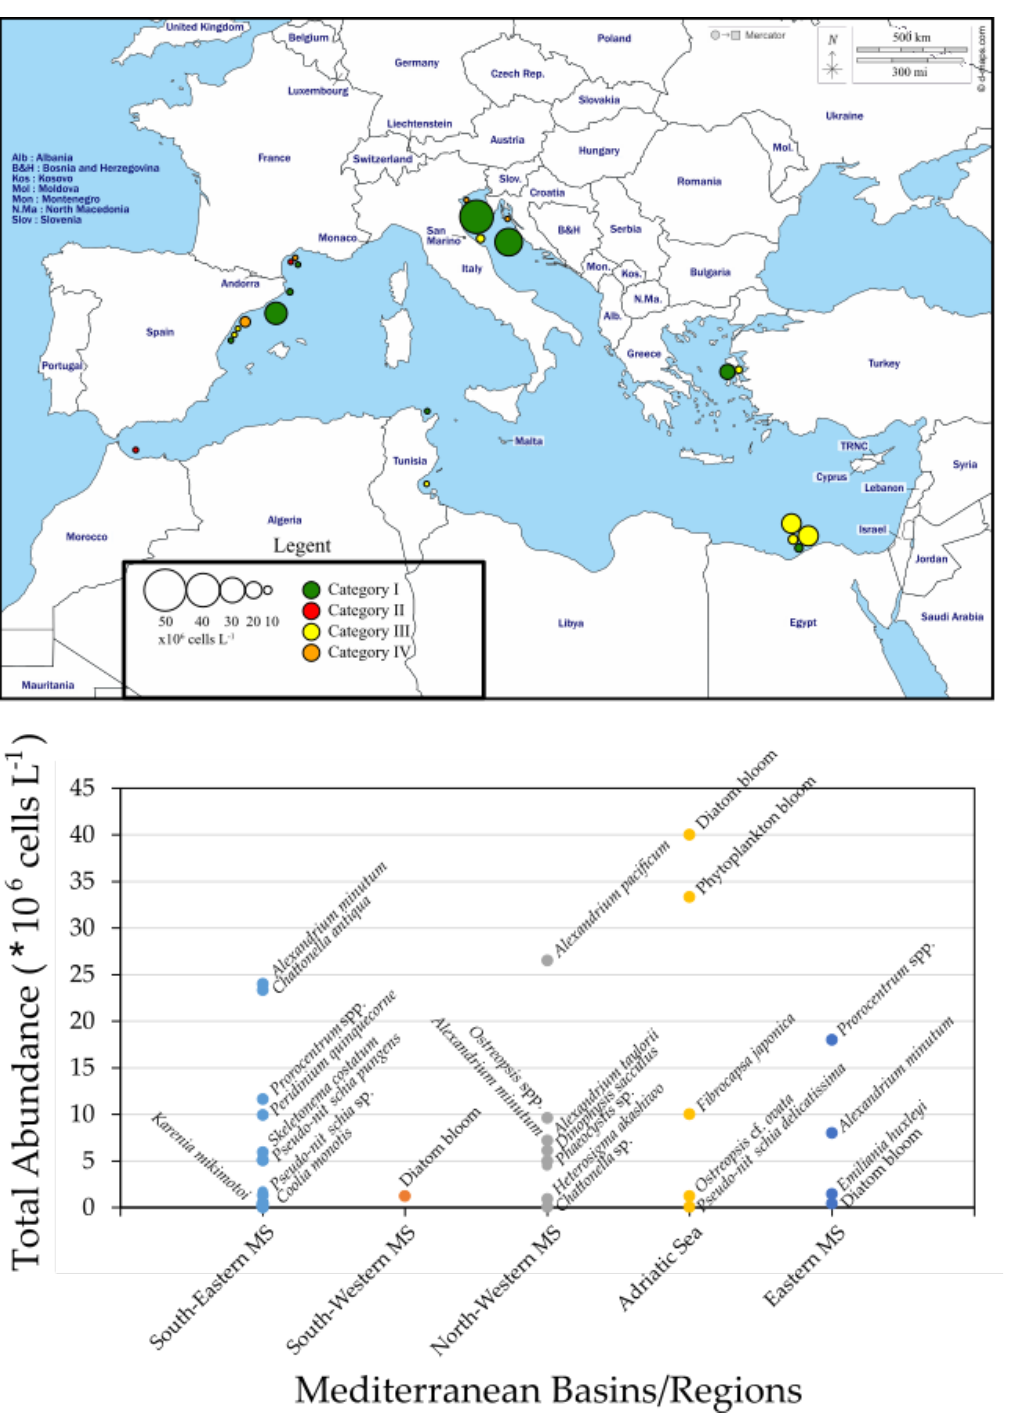
Figure 2. Top: major incidences of HABs in the MS. The size of the cycle represents the total abundance of the main taxa responsible for the blooms, and the color reflects the main category assigned to the HABs (see Table 1 for description of the four categories). Bottom: total abundance of phytoplankton in documented coastal HABs in the MS.